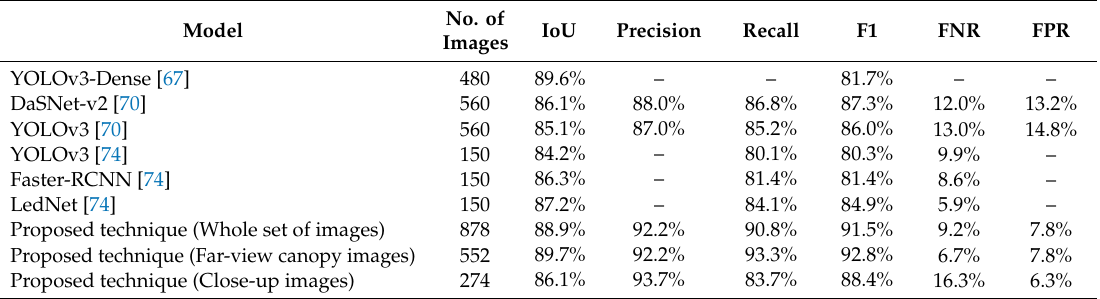
Table 3. Comparison to other